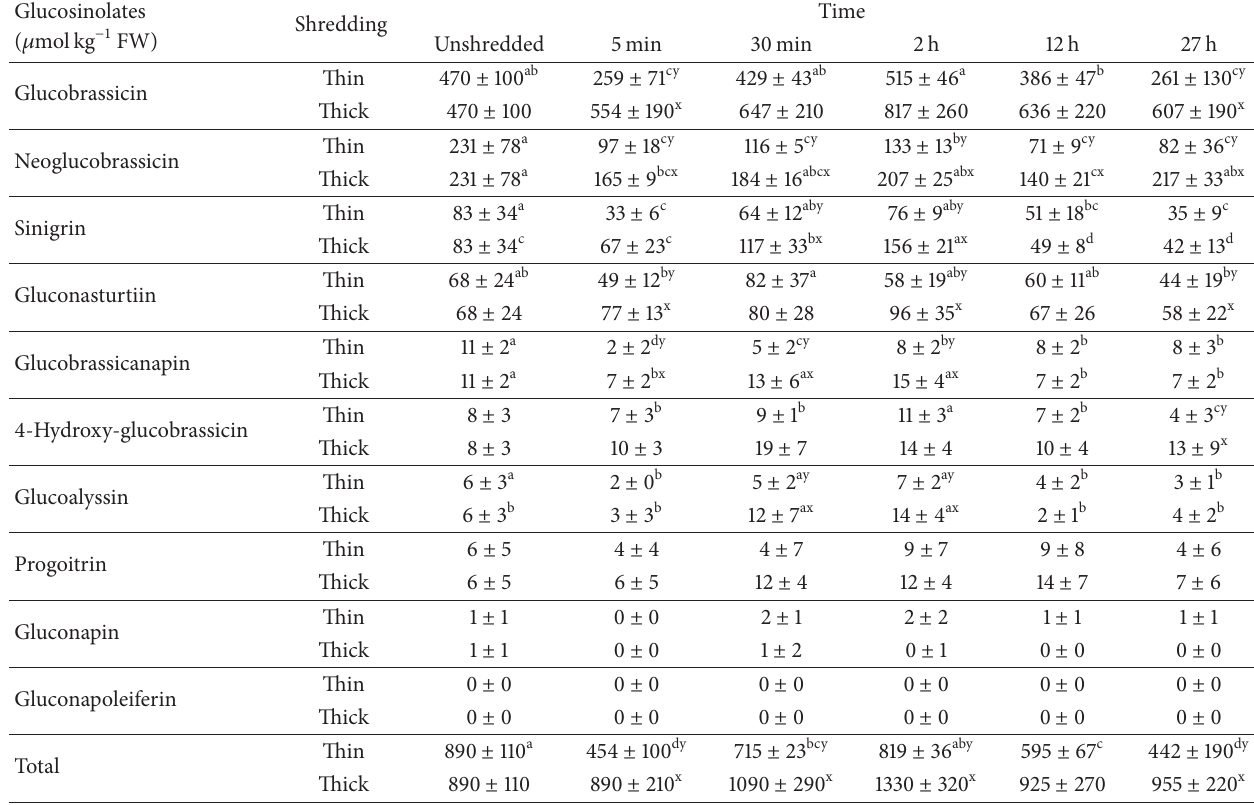
Table 3: Changes in the contents of the main GLS after 27 h storage, in comparison to unshredded